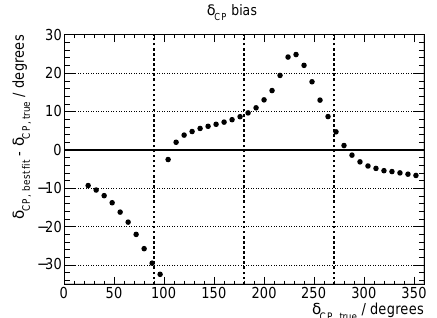
Figure 69. The δ CP bias as a function of true δ CP when performing a far detector-only fit with NuWro reweighted fake data. The black points show the resulting bias when using the nominal MC to predict what is observed at the far detector in the oscillation parameters